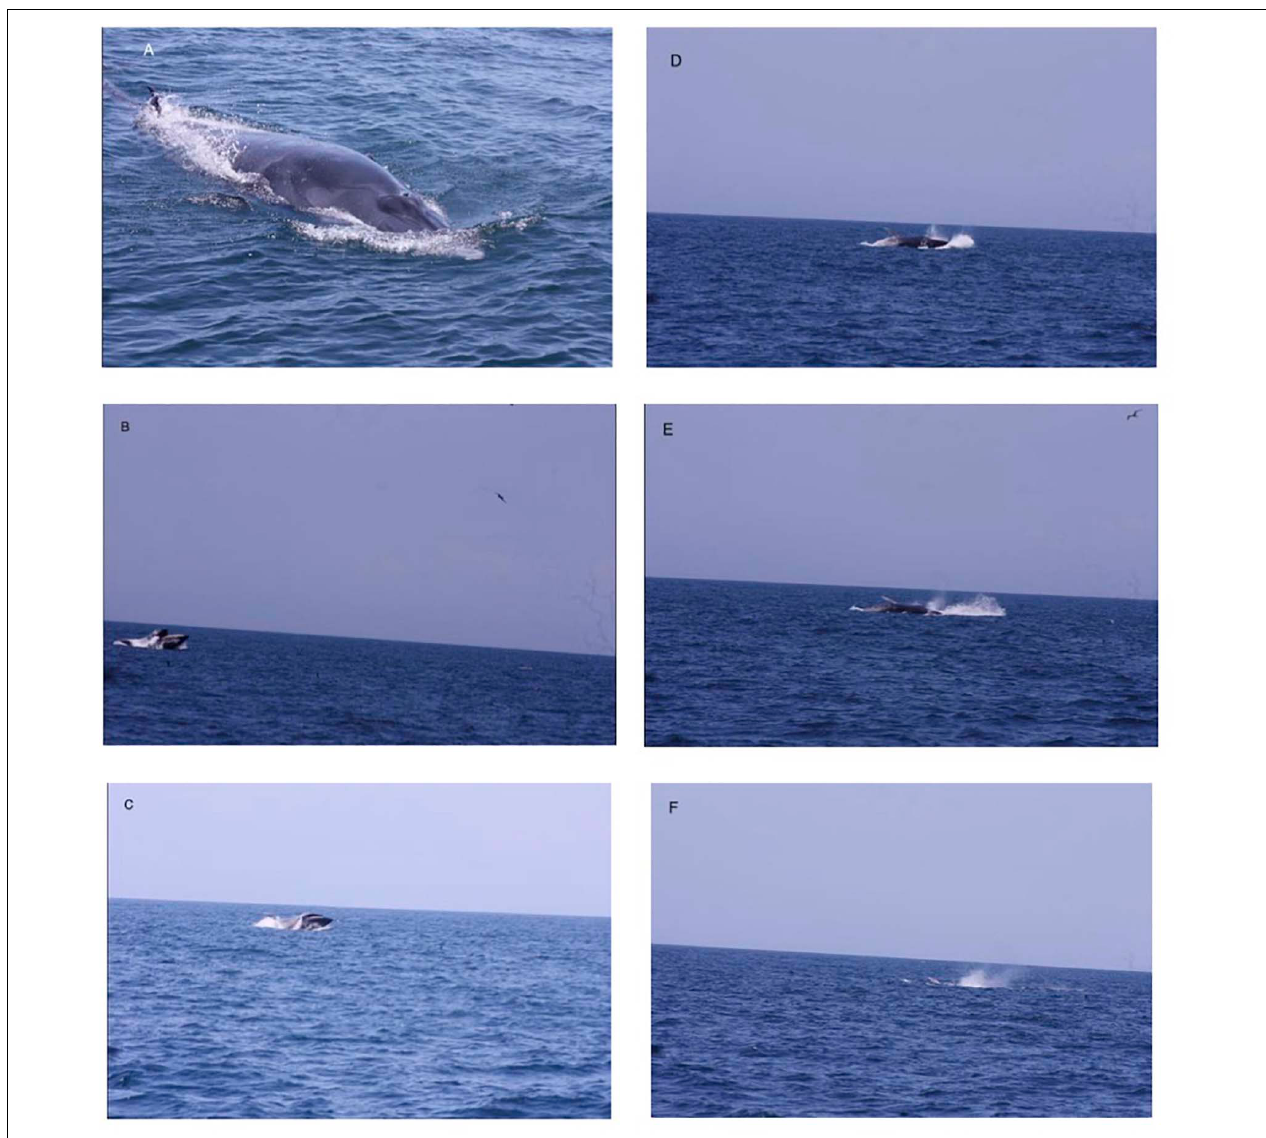
FIGURE 5 | (A) The three ridges on the head of a Bryde’s whale ( Balaenoptera edeni ). (B) The visible plates of a Bryde’s whale, with a gradation of the lighter white-gray at the front tip and the dark/black plate at the back. (B–F) The lunge feeding sequence of a Bryde’s whale encountered on 31 October 2015 (it did not reorient itself to dive with the dorsal fin exposed per de Mello Neto et al.,